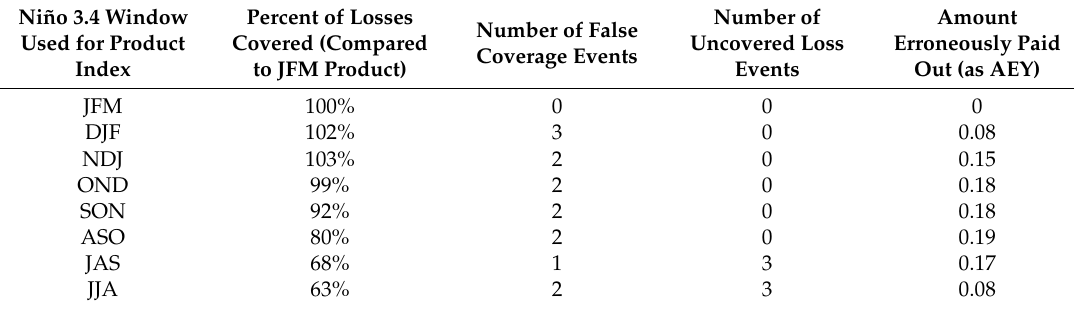
Table 2. Percent losses covered, basis risk events, and erroneous payments for product conditioned on predicted JFM Niño 3.4 values from incrementally shifted seasonal